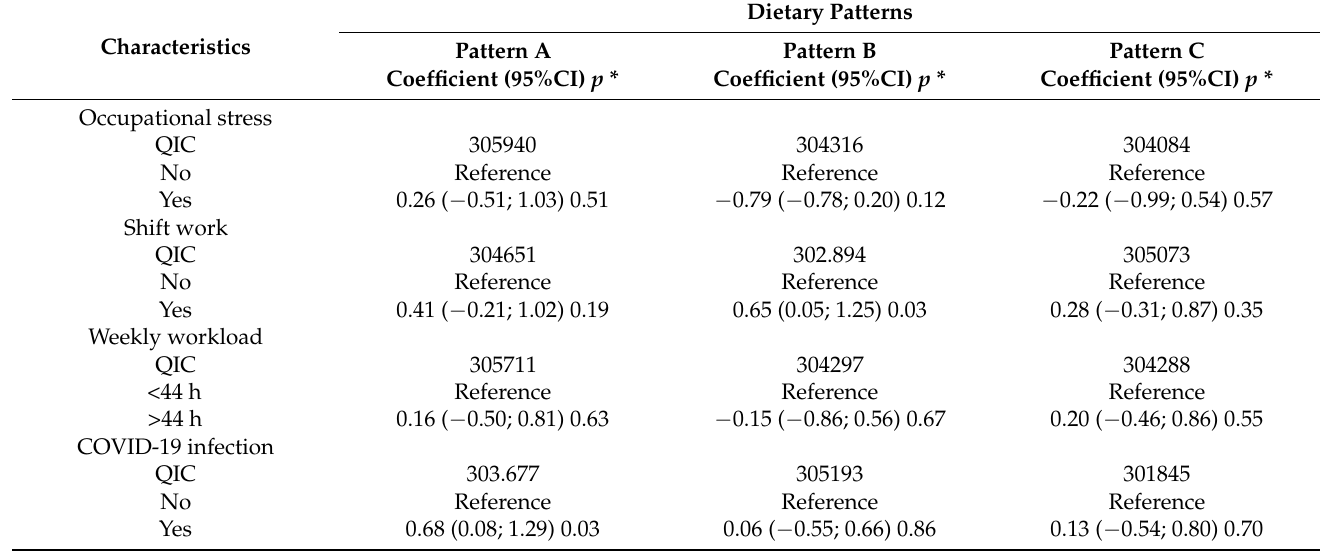
Table 4. Generalized Estimating Equations models for the relationship between occupational stress and work stressors and the dietary pattens over time. Santo Ant ô nio de Jesus city,